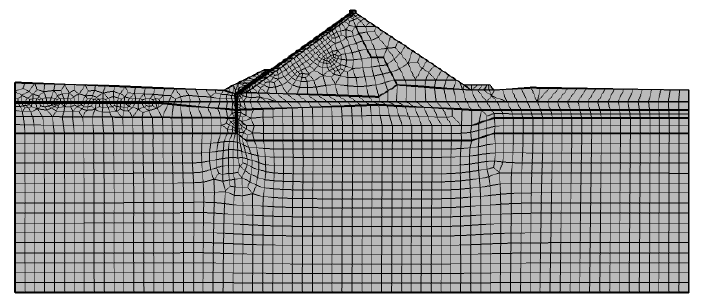
Figure 7. 2D FE mesh of Kakiwa dam.